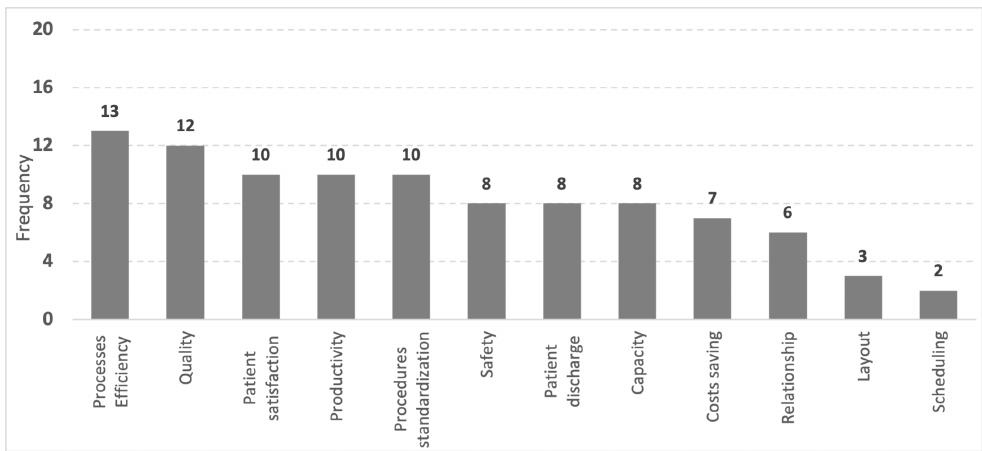
Figure 3. Main improvements identified in the literature after Lean implementation in